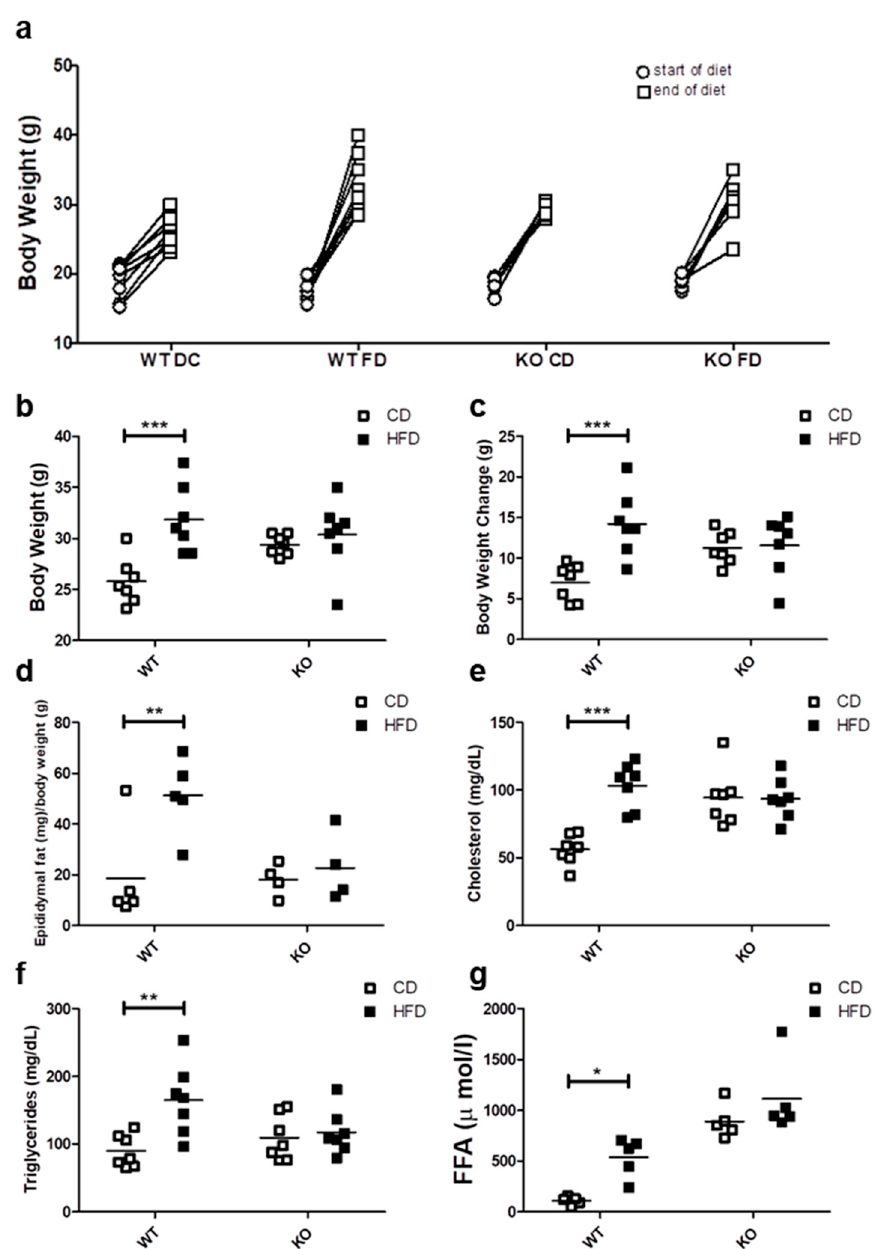
Figure 1. Metabolic characterization of male C57BL6J wild type (WT) and C57BL6J caveolin-1 knock-out (CAV1 KO) mice. ( a ) The body weight at the beginning (circles) and the end (squares) of the 12 weeks for mice on control diet (CD) or high fat diet (HFD) ( n = 7). ( b ) Final body weight at the end of diets ( n = 7). ( c ) Body weight changes between the beginning and the end of diets ( n = 7). ( d ) The animals were sacrificed to determine the epididymal fat ( n = 5). Serum samples were taken in order to evaluate the blood levels of ( e ) total cholesterol ( n = 7), ( f ) triglycerides ( n = 7) and ( g ) free fatty acids (FFA, n = 5). Mice were maintained for 6 h in fast conditions before the blood samples were taken. p values were calculated by two-way ANOVA with a Bonferroni post-test (* p < 0.05, ** p < 0.01 and *** p < 0.001). Data are presented as individual data points with their respective means.